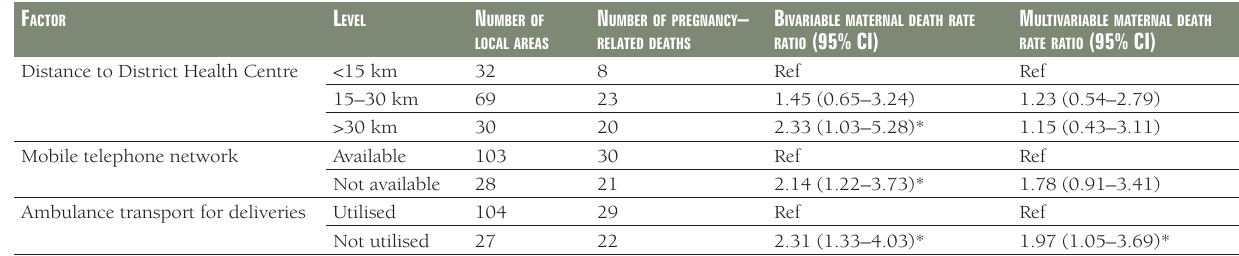
Table 2. Associations between maternal deaths and distance to District Health Centre, availability of mobile telephone network and utilisation of ambulance transport for deliveries in 131 local areas ( tabia ) in Tigray Region, Ethiopia, using a Poisson regression model.